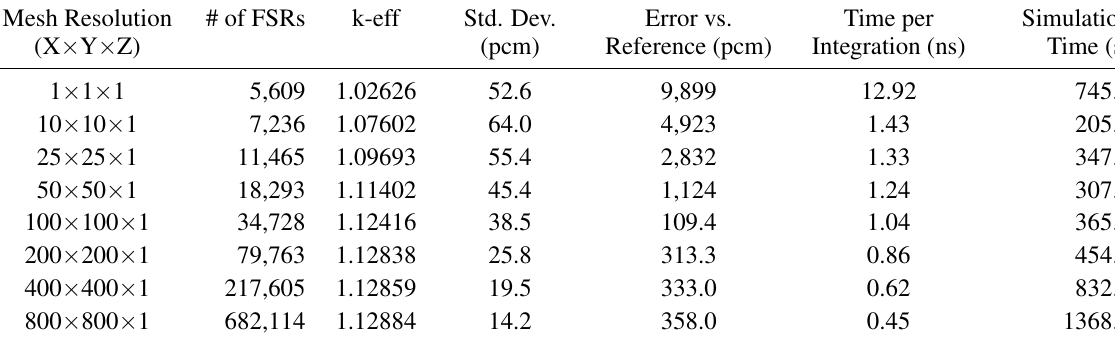
Table 2: Results of a the Cartesian mesh refinement study performed using a dual-socket Intel Xeon Platinum 8180M node with 56 total cores. Using 110 threads, all simulations used 17,000 rays per iteration with a distance of 250 cm per ray to meet the Source Averaged Relative Error (SARE) < 0.003 condition